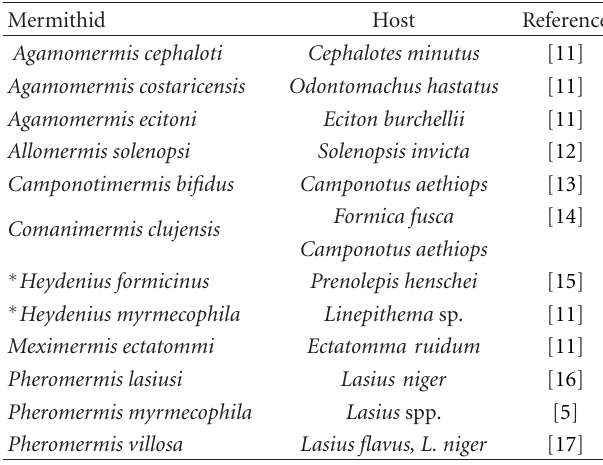
Table 2: Mermithid nematodes described from